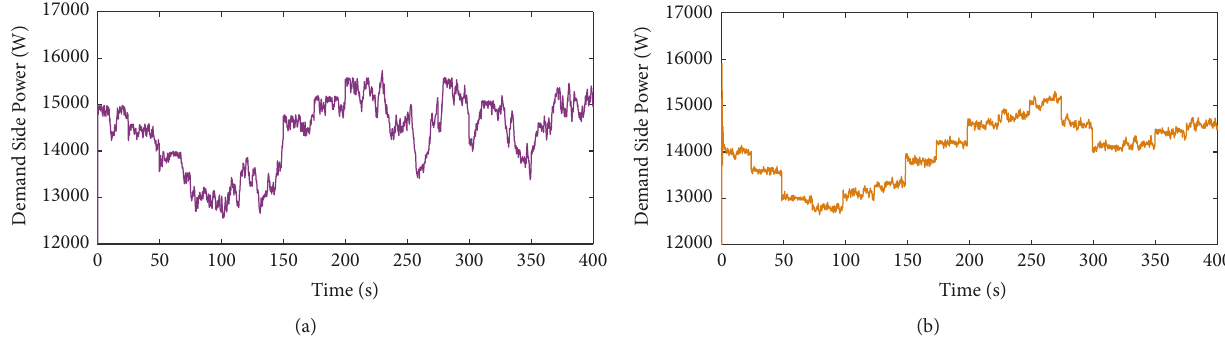
Figure 22: Demand side power waveform with loads change. (a) ES is not activated. (b) ES is